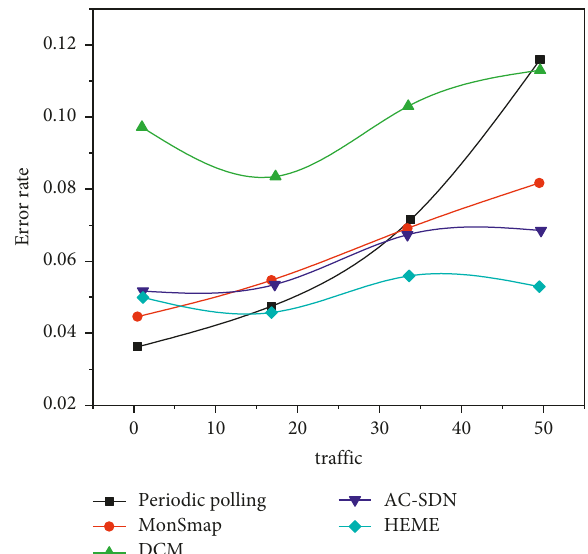
Figure 7: Comparison of monitoring error